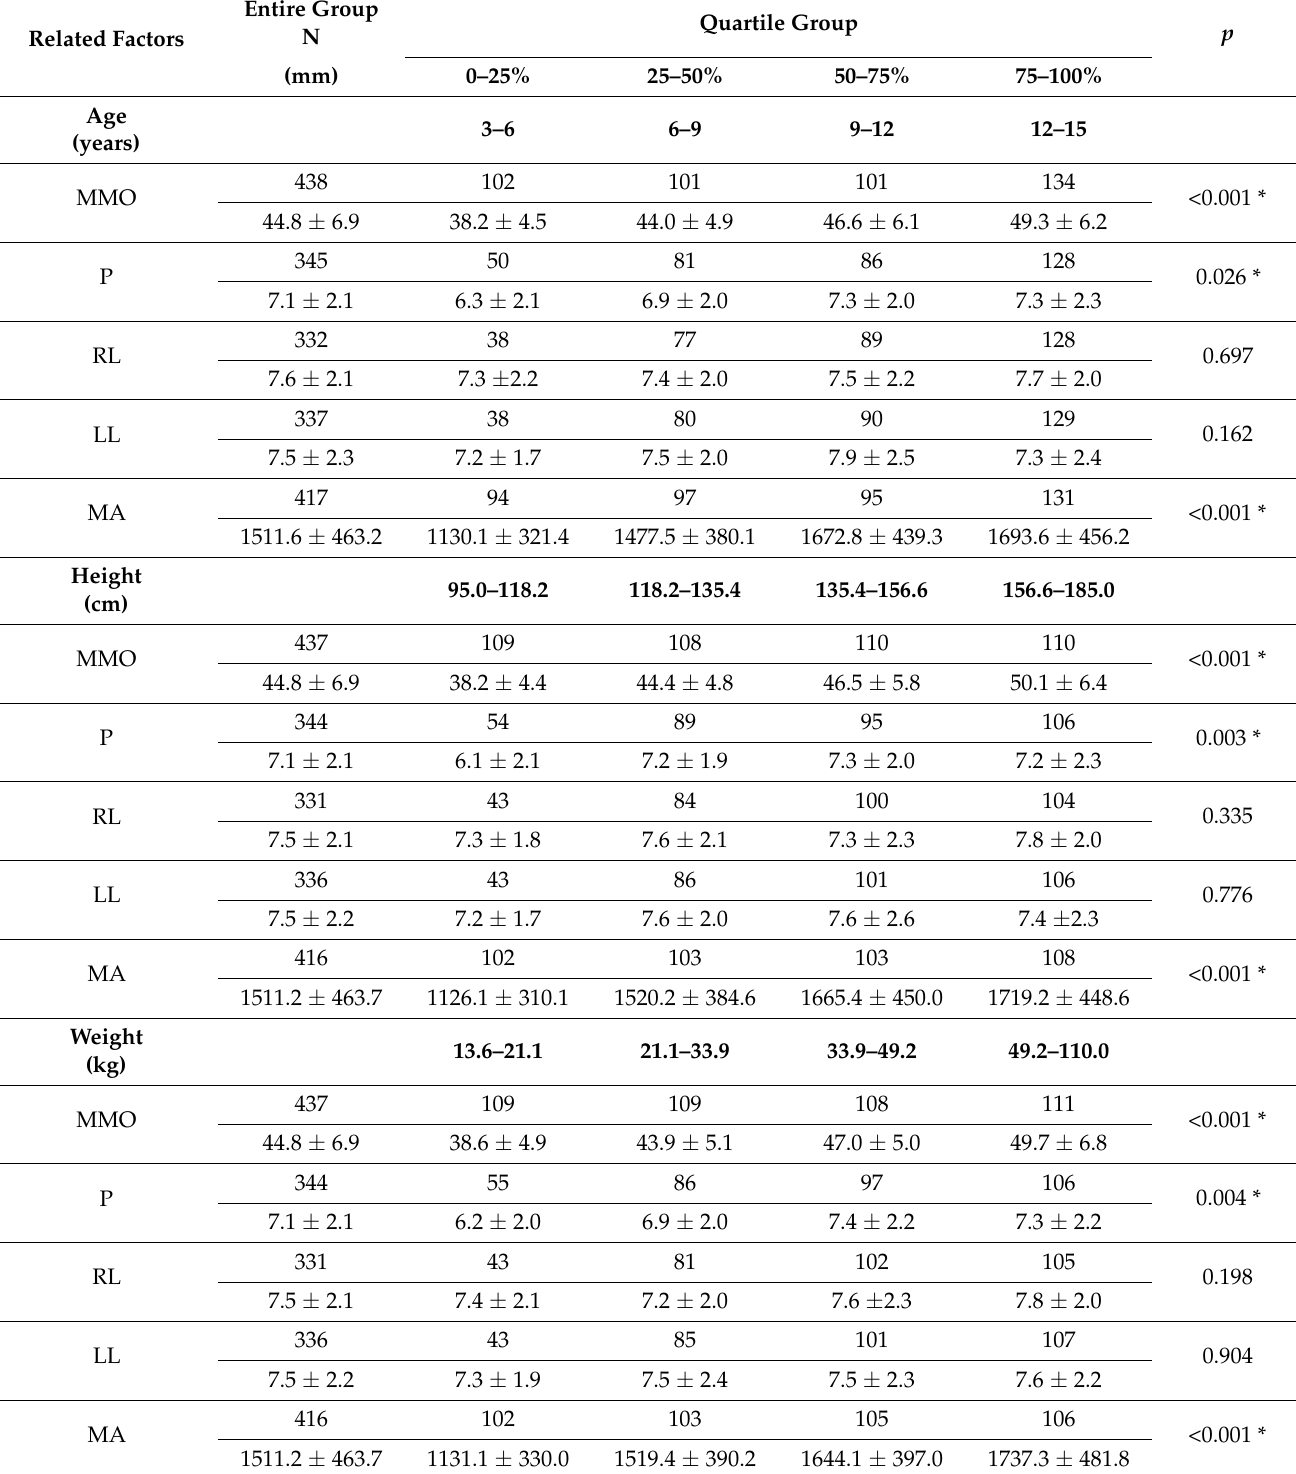
Table A2. Data analysis of mandibular range of motion in quartile groups according to age, height, weight, body mass index, and mouth